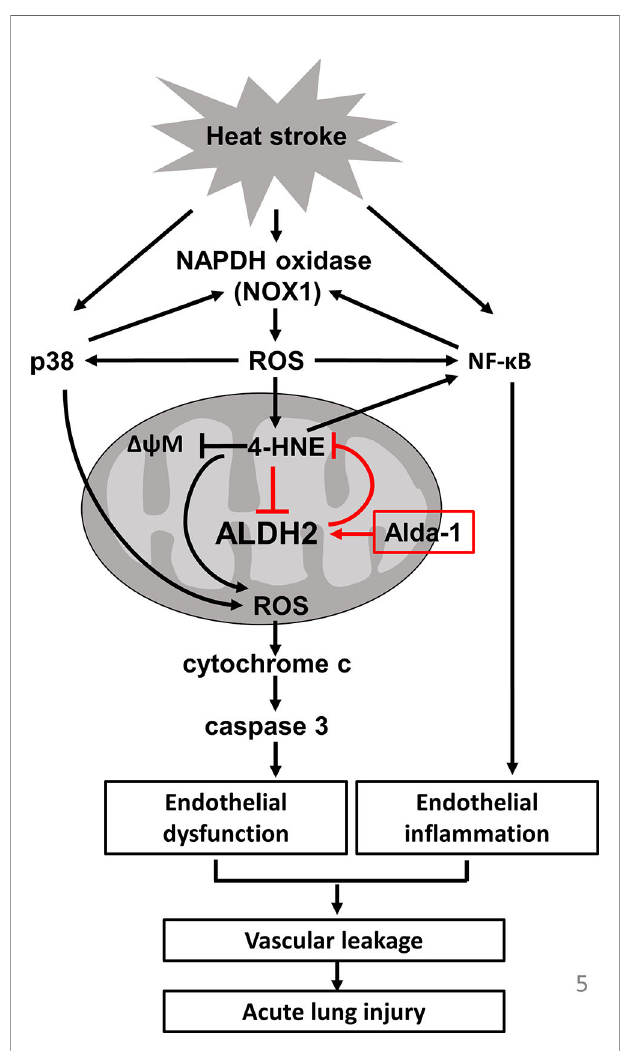
FIGURE 5 | Schematic of the role of ALDH2 in